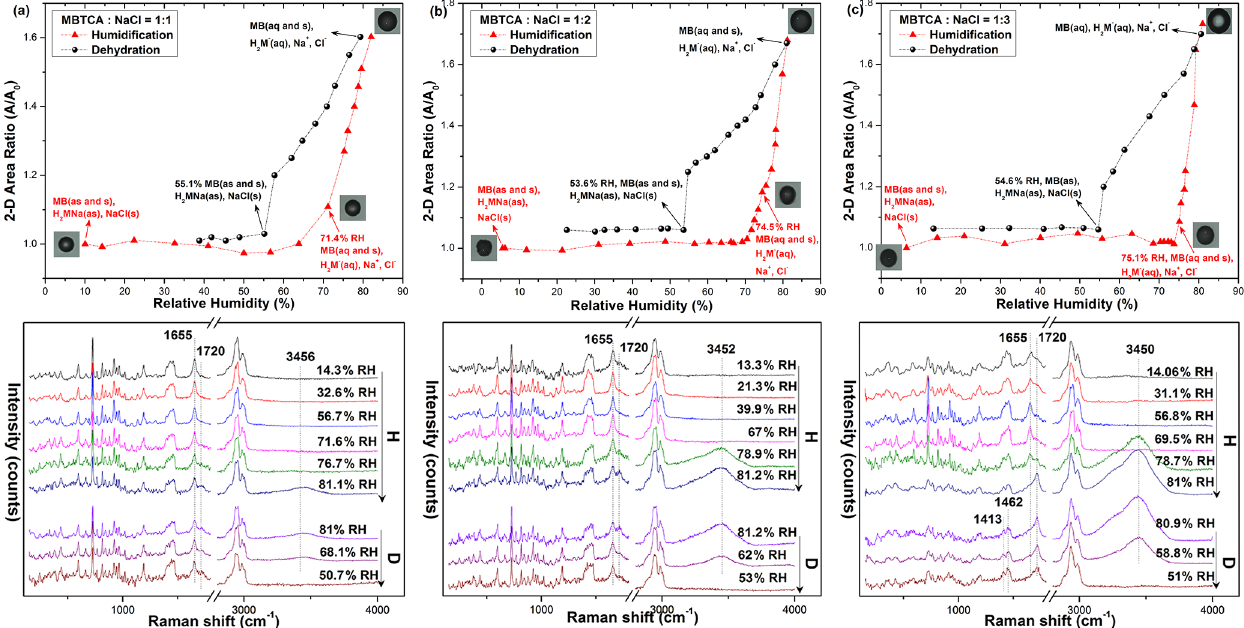
Figure 9. Hygroscopic curves, corresponding optical images, and Raman spectra at specific RHs of MBTCA:NaCl = (a) 1:1, (b) 1:2, and (c) 1:3 mixture particles in the levitation system. The recorded transition RHs during the humidification (H) and dehydration (D) processes and the chemical compositions of the mixtures at certain RHs are marked with arrows in the hygroscopic curves. The phase notations shown in parentheses are s – solid, aq – aqueous, and as – amorphous